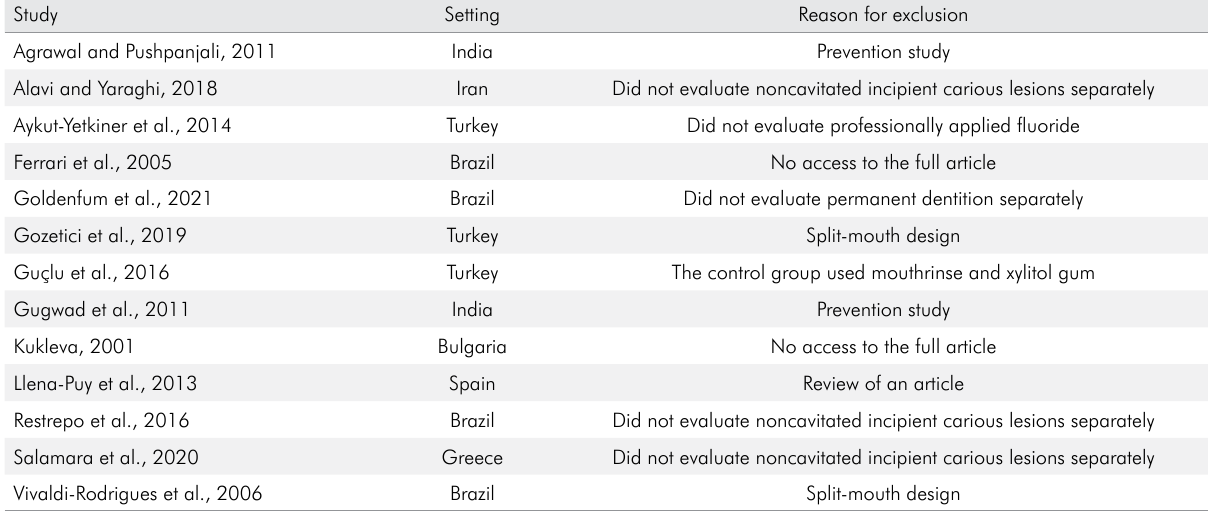
Table 2. Excluded studies and main reasons for